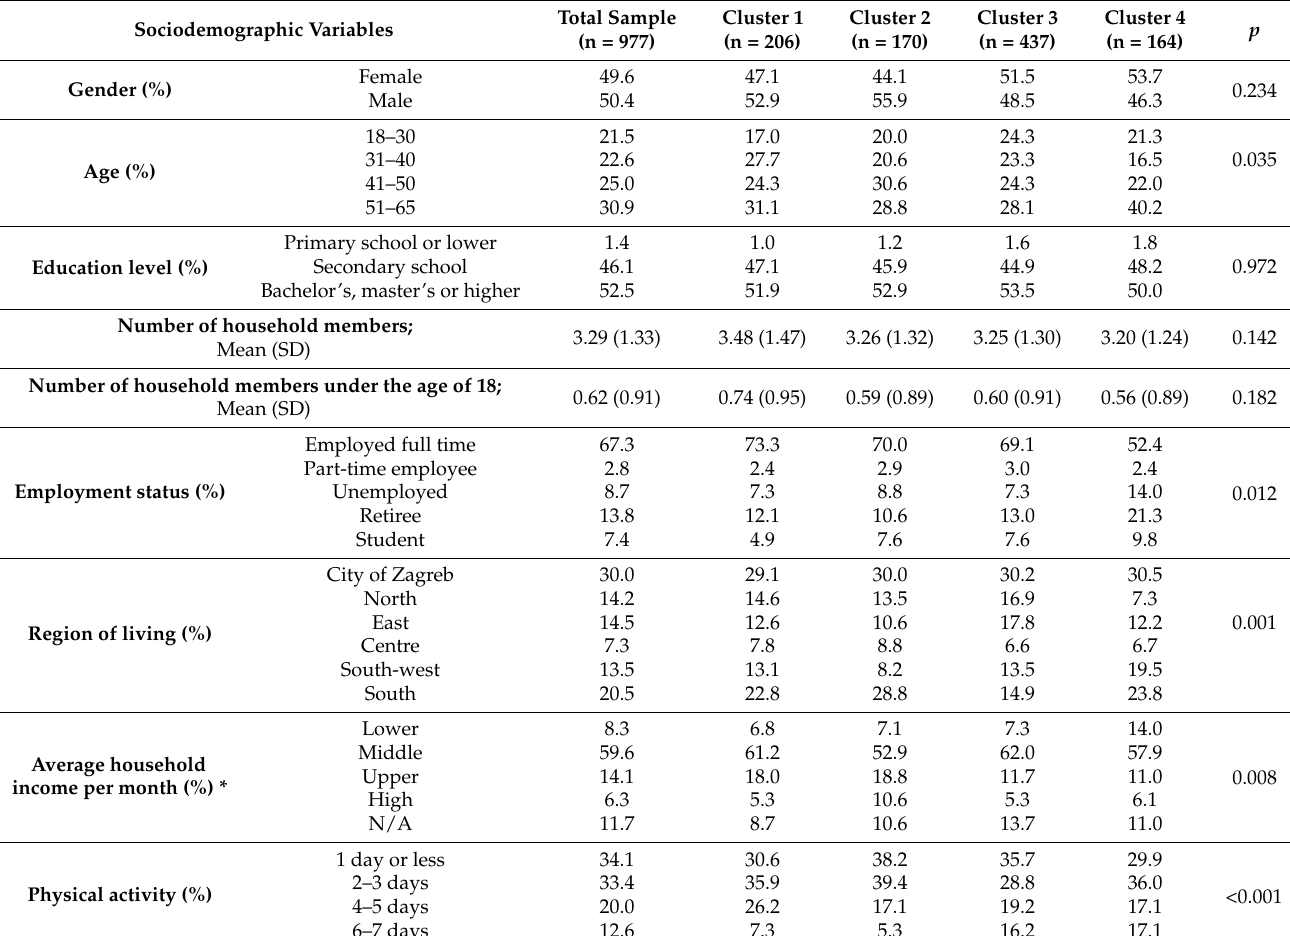
Table 2. Sociodemographic characteristics of study sample (n =